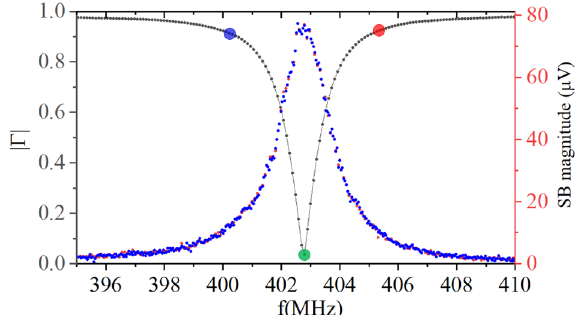
Ŵ (in black ) and magnitudes of demodulated sidebands | | 240 nH and = V g at f Mod = 8 kHz ˜